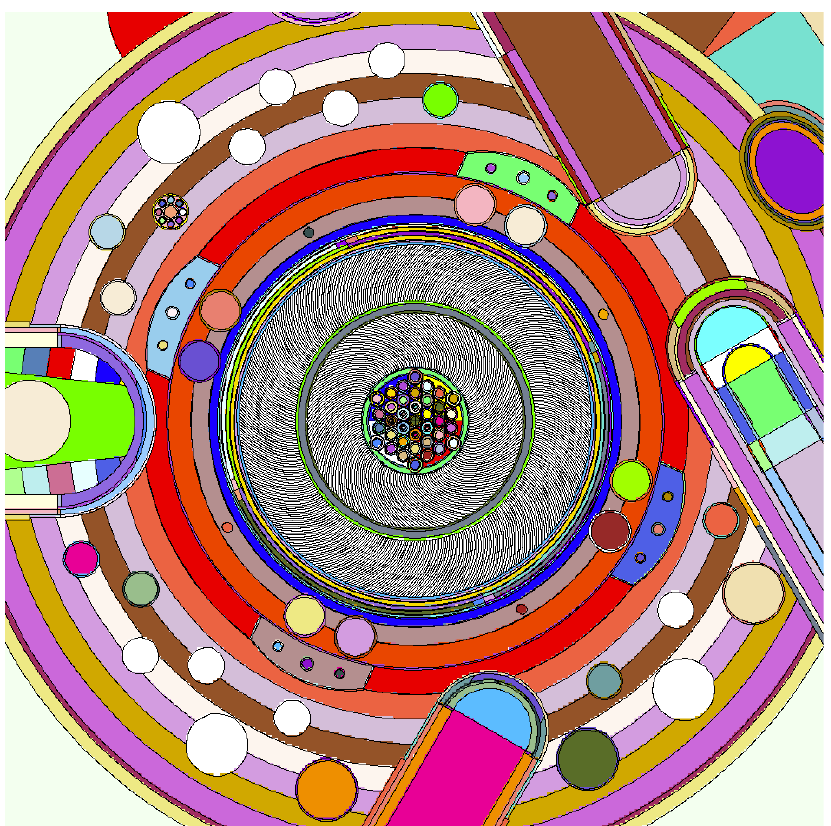
FIGURE 1. HFIRGeometry with a Representative Experiment Loading [5]. The colors denote different cells modeled in